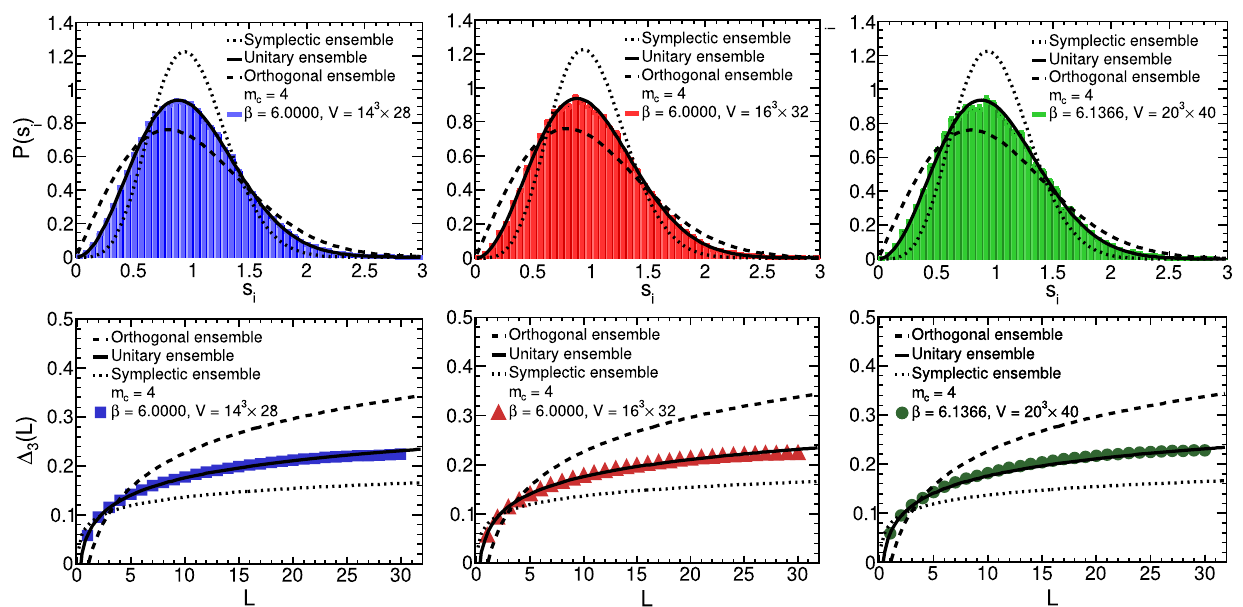
Fig. 10 The distributions of the nearest neighbor spacing P ( s i ) (upper figures) and the spectral rigidity (cid:11) 3 ( L ) (lower figures) compared with the GRMT. The magnetic charges are m c = 4. The lattices are β = 5 . 8457 , V = 12 3 × 24 (upper and lower left), β = 6 . 0000 , V = 14 3 × 28(upperandlowermiddle),and β = 6 . 0000 , V = 16 3 × 32 Fig. 11 Comparing the ratios of the low-lying eigenvalues (cid:5) ¯ λ | Q | (cid:6) k in each topological charge (cid:5) ¯ λ | Q | (cid:6) j sector | Q | = 0 , 1 , and 2 with the prediction of the chRMT and examining the effects of the finite lattice volume and the discretization. The black and colored symbols indicate the numerical results of the normal configuration and magnetic charge m c = 4 . The black horizontal lines indicate the predictions of the